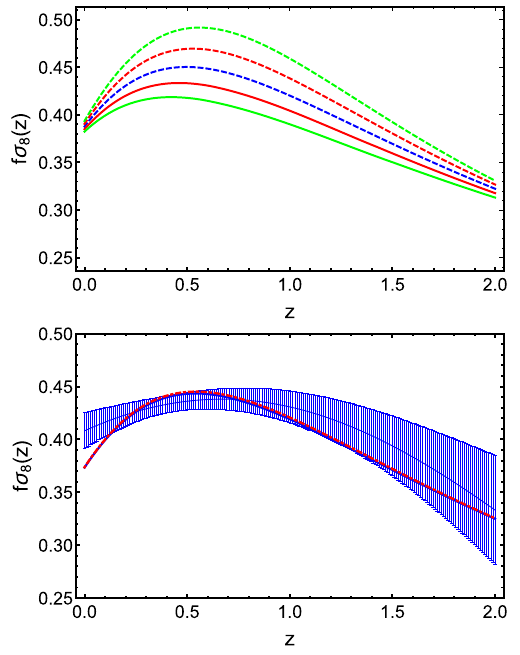
Fig. 6 Inthetop,wecanseethe f σ 8 observableforthe (cid:5) CDM model for different values of the curvature parameter using numerical solu- tions. We use the following values of the curvature parameter (from the upper curve to the lower one): (cid:3) k 0 = − 0 . 2 , − 0 . 1 , 0 , 0 . 1 , 0 . 2. In the bottom, we shown the non-parametric reconstruction of the observable f σ 8 and the blue curve represents the best fit for the flat case and the dashed red curve represents the best fit for the non-flat